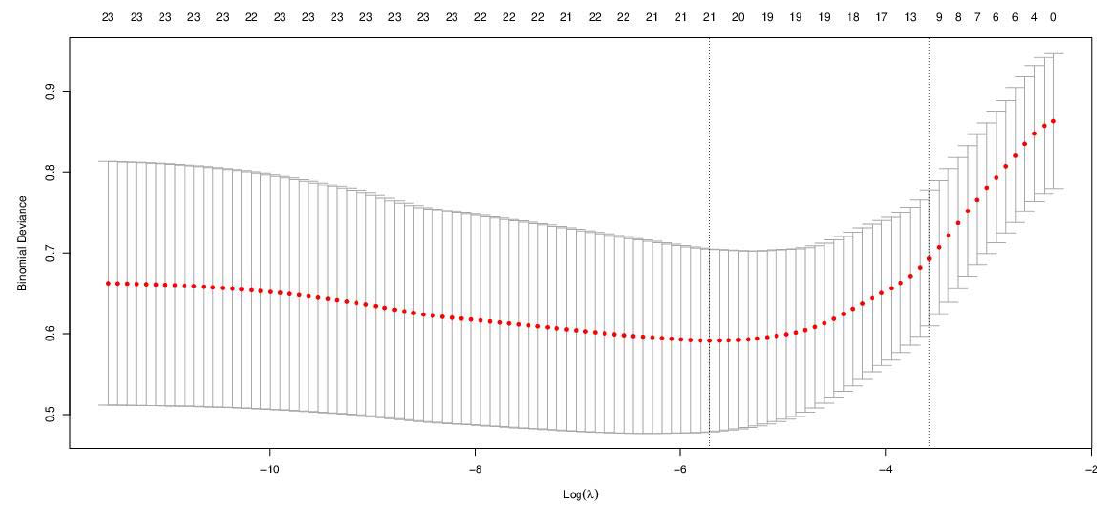
Figure 4. Graphical representation of the cross-validation outputs. The lambda interval delimited by the two vertical lines identifies the optimal selection range.